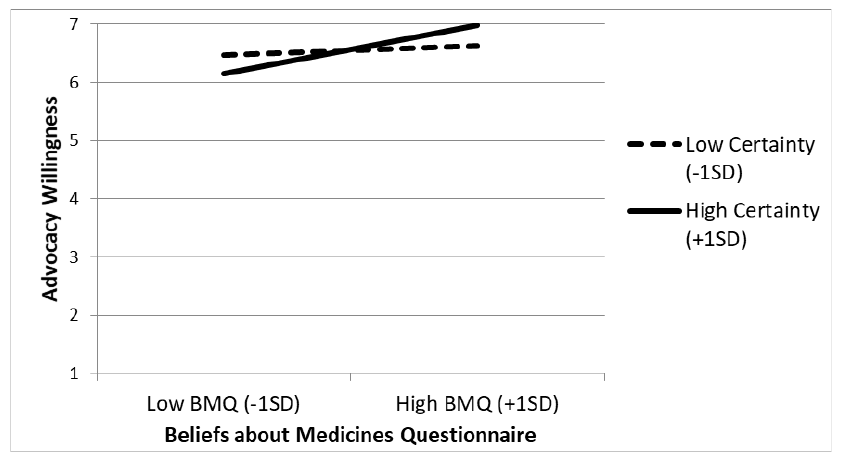
Figure 1. Study 1. Advocacy Willingness as a Function of BMQ Responses and Reported Meta-Cognitive Certainty.